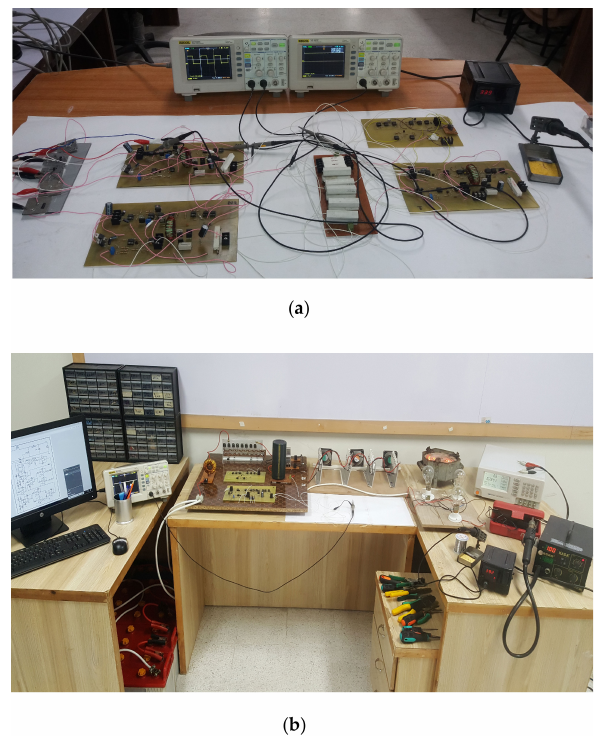
Figure 4. Experimental set-up for the proposed technique. ( a ) 24 V setup; ( b ) 110 V setup.